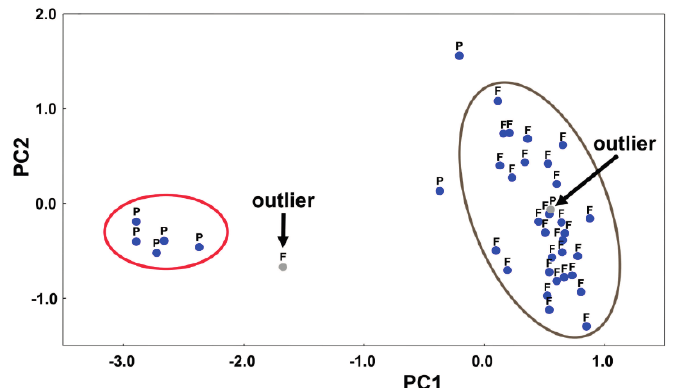
Figure 13. Distribution of samples in the reduced bi-dimensional factor space given by the first and second principal components (PC1 and PC2, respectively). The labels “F” and “P” refer to “fluvent” and “psamment” soil classes, respectively. The arrows indicate possible